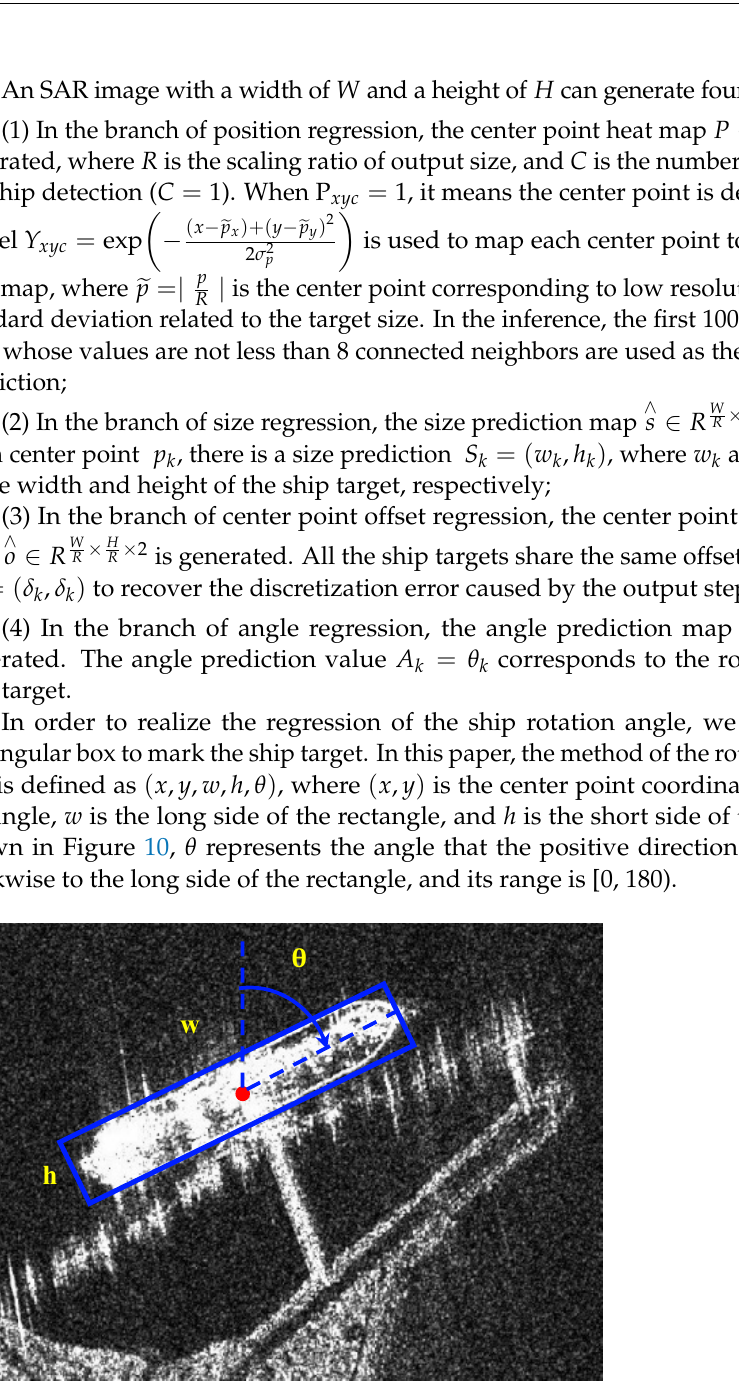
Figure 10. The schematic diagram of the rotating bounding box.